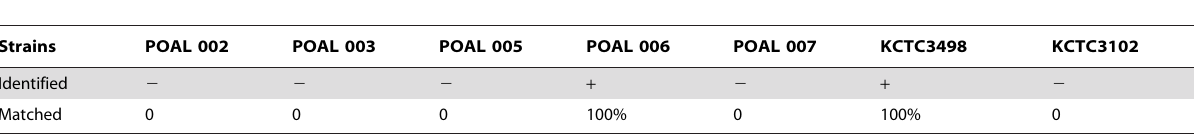
Table 5. Viability of L. brevis strains in the mouse intestine after administration for 1 week.